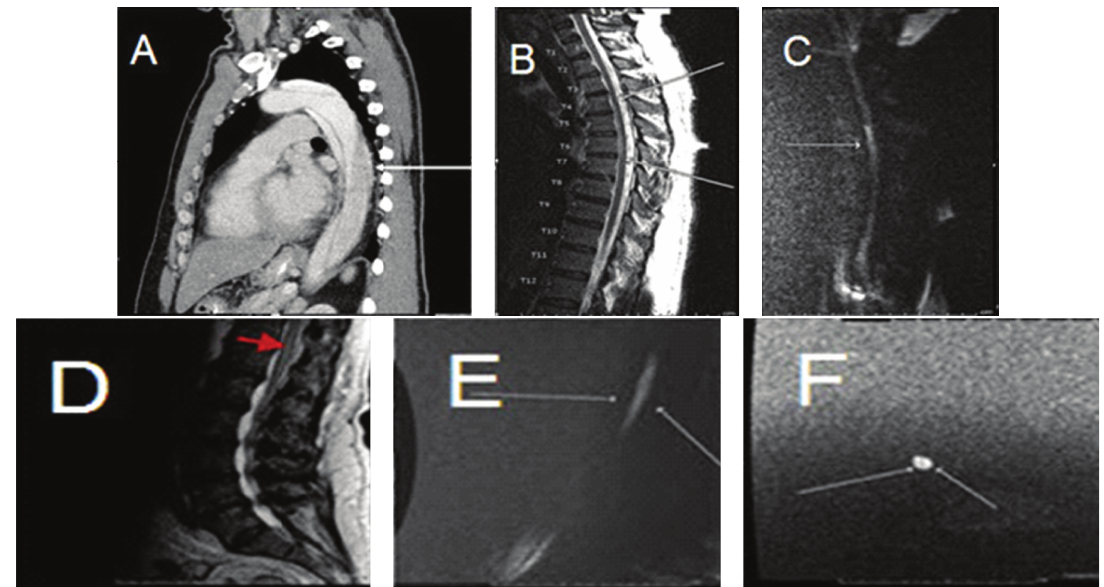
Figure 1: (A) Sagittal CT thorax/abdomen with contrast showing type B aortic dissection beginning distal to the origin of the left subclavian artery. Note the false lumen extending to the inferior mesenteric artery. (B) and (C) Sagittal T2 and DWI MRI of the thoracic spine. Note the abnormal hyperintense signal within the anterior portion of the central gray matter from level T4 to T7 with associated mild cord swelling denoted in (B) and the corresponding di ff usion restriction in the same area in (C). (D) Sagittal T2-weighted MRI denoting swelling of the conus with T2 bright signal (red arrow). A sagittal DWI-positive image (E) followed by an axial DWI-positive sequence in